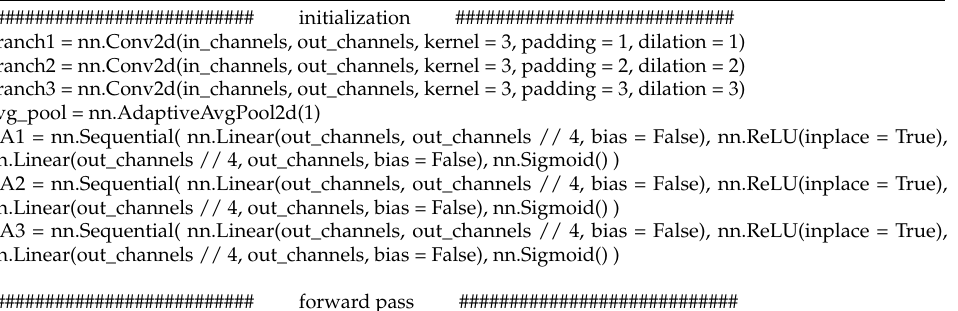
Algorithm 1 Pseudocode of Multi-scale Context Aggregation Module with three branches in a PyTorch-like